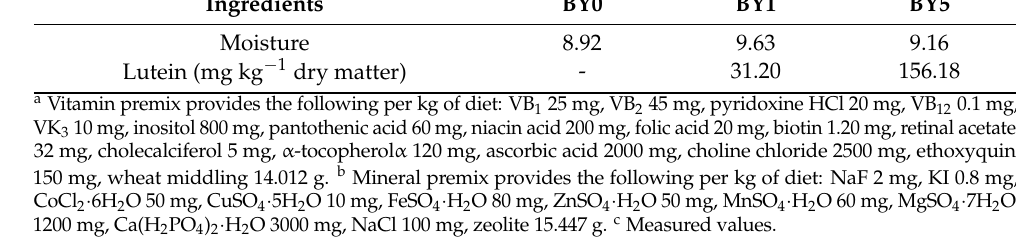
Table 1. Cont. Ingredients BY0 BY1 BY5 Moisture 8.92 9.63 9.16 Lutein (mg kg − 1 dry matter) - 31.20